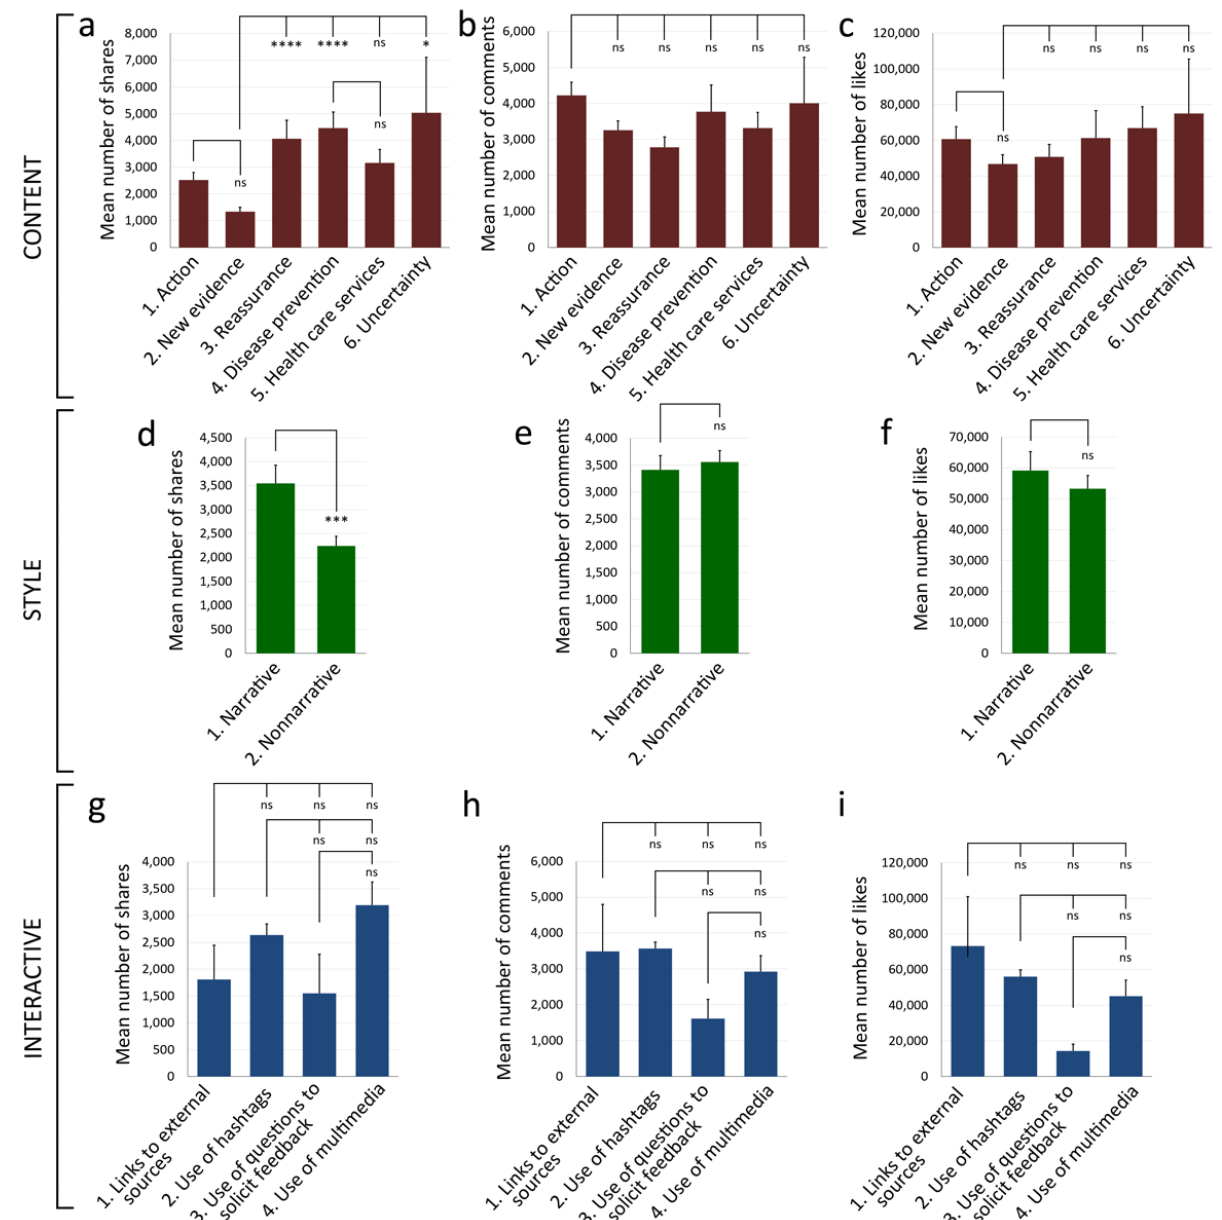
Figure 2. Comparison of the mean number of shares, comments, and likes for posts of each subdimension. Mean number of (a) shares, (b) comments, and (c) likes of the subdimensions of the content dimension. Mean number of (d) shares, (e) comments, and (f) likes of the subdimensions of the style dimension. Mean number of (g) shares, (h) comments, and (i) likes of the subdimensions of the interactive dimension. * P <.05, ** P <.01, *** P